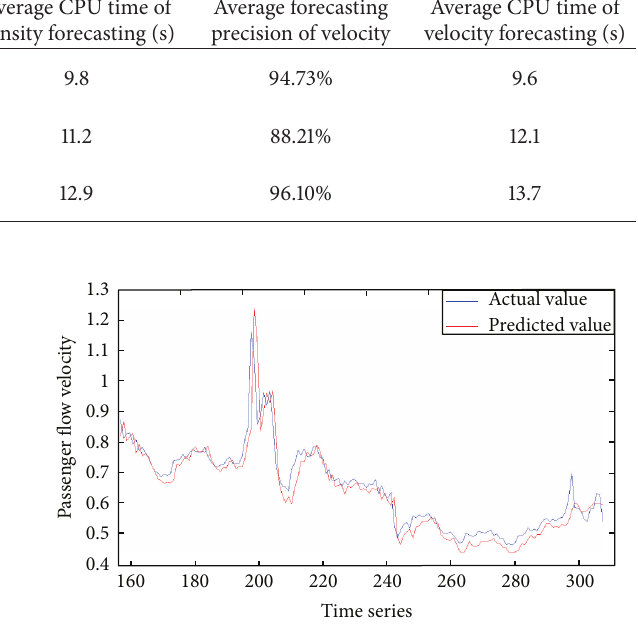
Figure 7: Comparion between actual value and forecasting value of passenger flow density based on hybrid temporal-spatio forecasting approach.